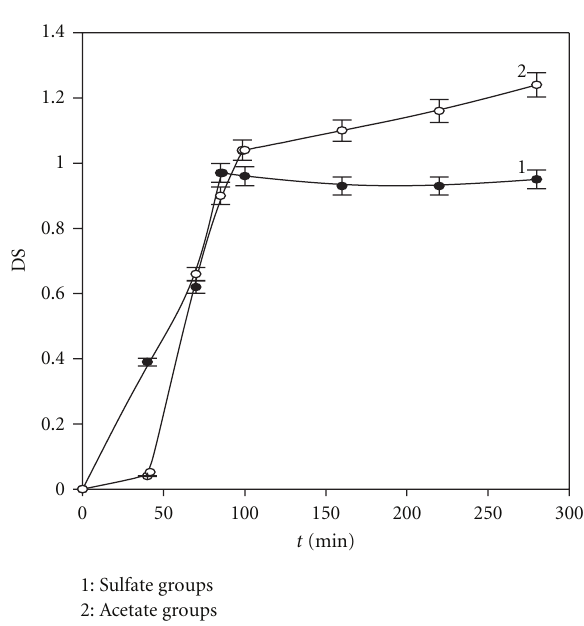
Figure 2: Curves of functional groups accumulation in the polymer at the homogeneous synthesis of